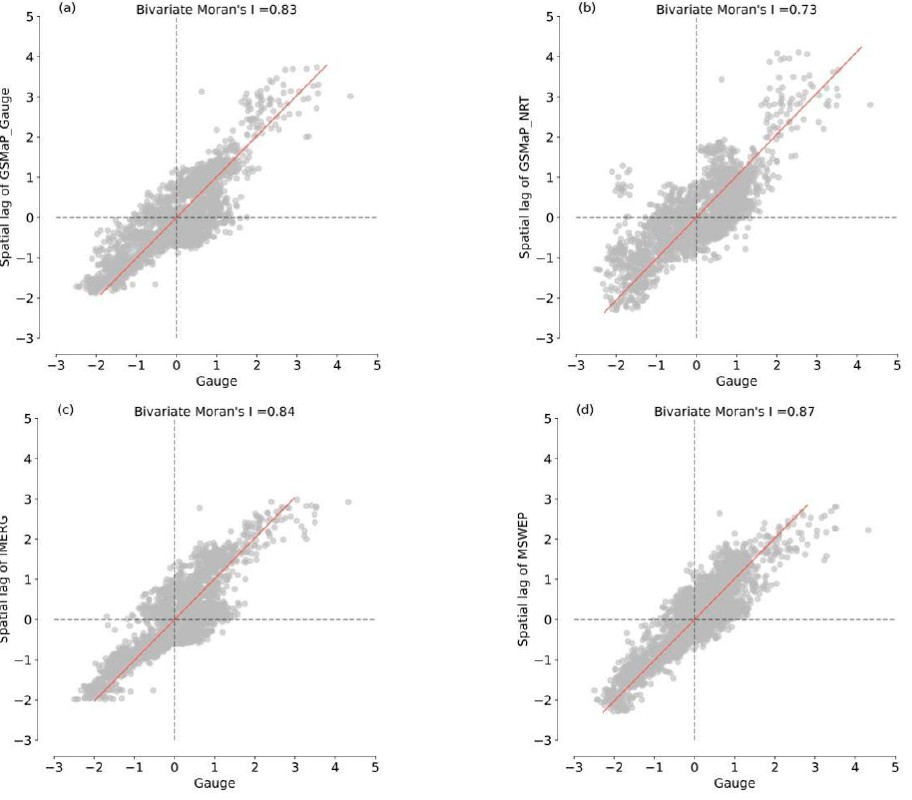
Figure 10. The global BMI scatter plot of R95 between the gauge observations and the four SPPs: ( a ) GSMaP_Gauge, ( b ) GSMaP_NRT, ( c ) IMERG and ( d ) MSWEP. The results indicate that the GSMaP_Gauge, IMERG, and MSWEP accurately